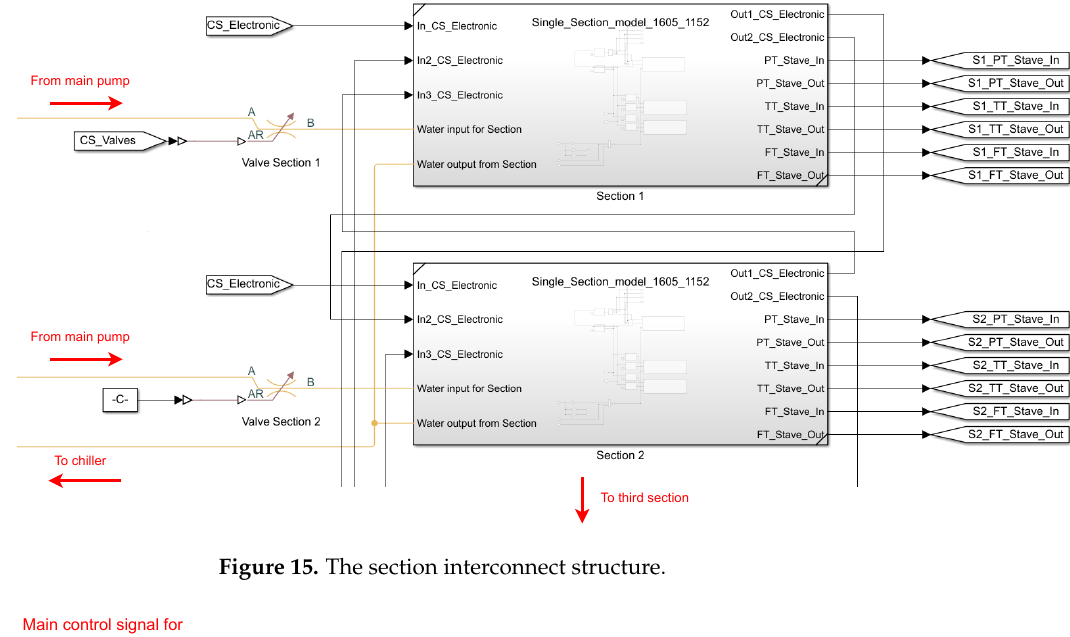
Figure 15. The section interconnect structure.